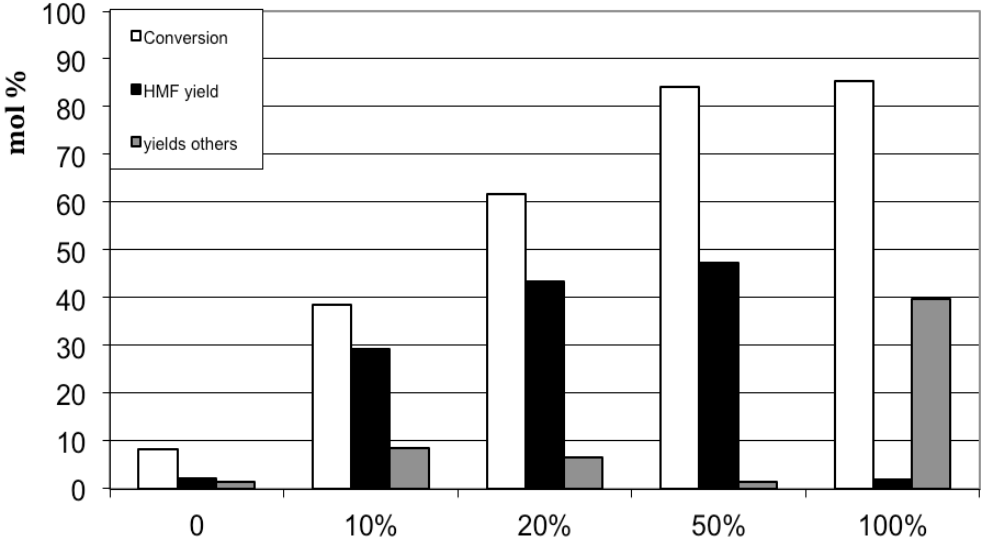
Figure 13. Fructose conversion in 5-HMF obtained in acetic acid aqueous solutions of various compositions in the absence of added solid catalyst.